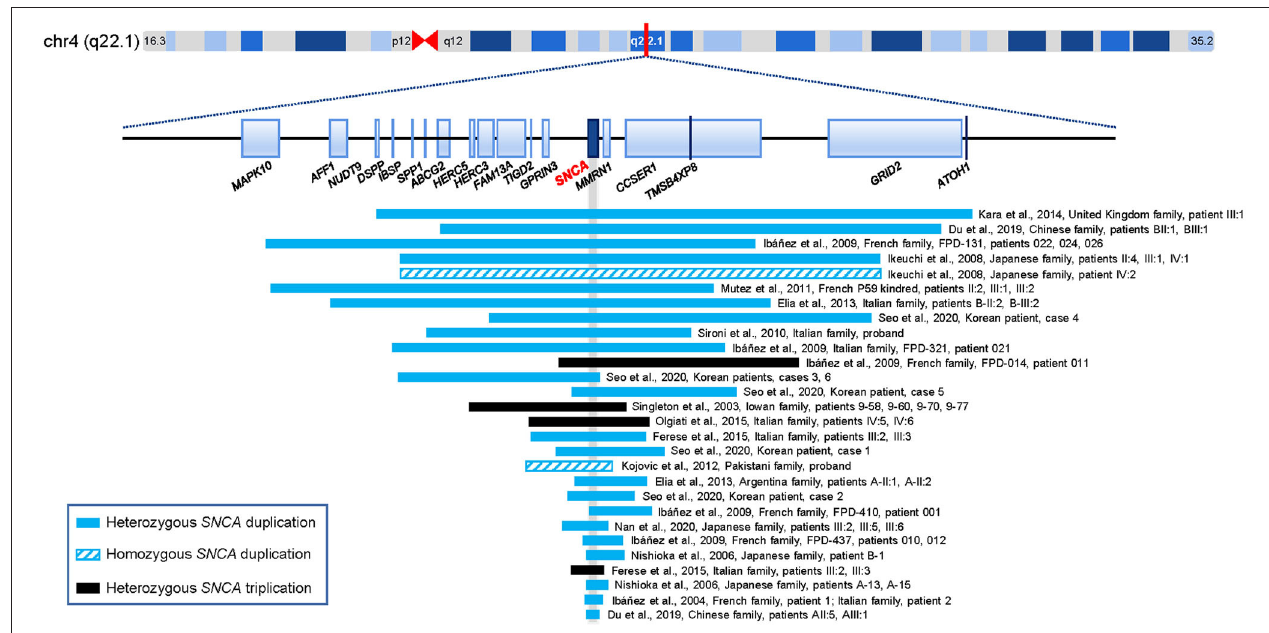
FIGURE 2 | The reported duplications and triplications including the SNCA locus for parkinsonism (i.e., bar sizes are not in proportion). The gray vertical bar indicates the position of the SNCA gene. The raw data and corresponding references are available in Supplementary Table 2 . Genome size is based on human genome build